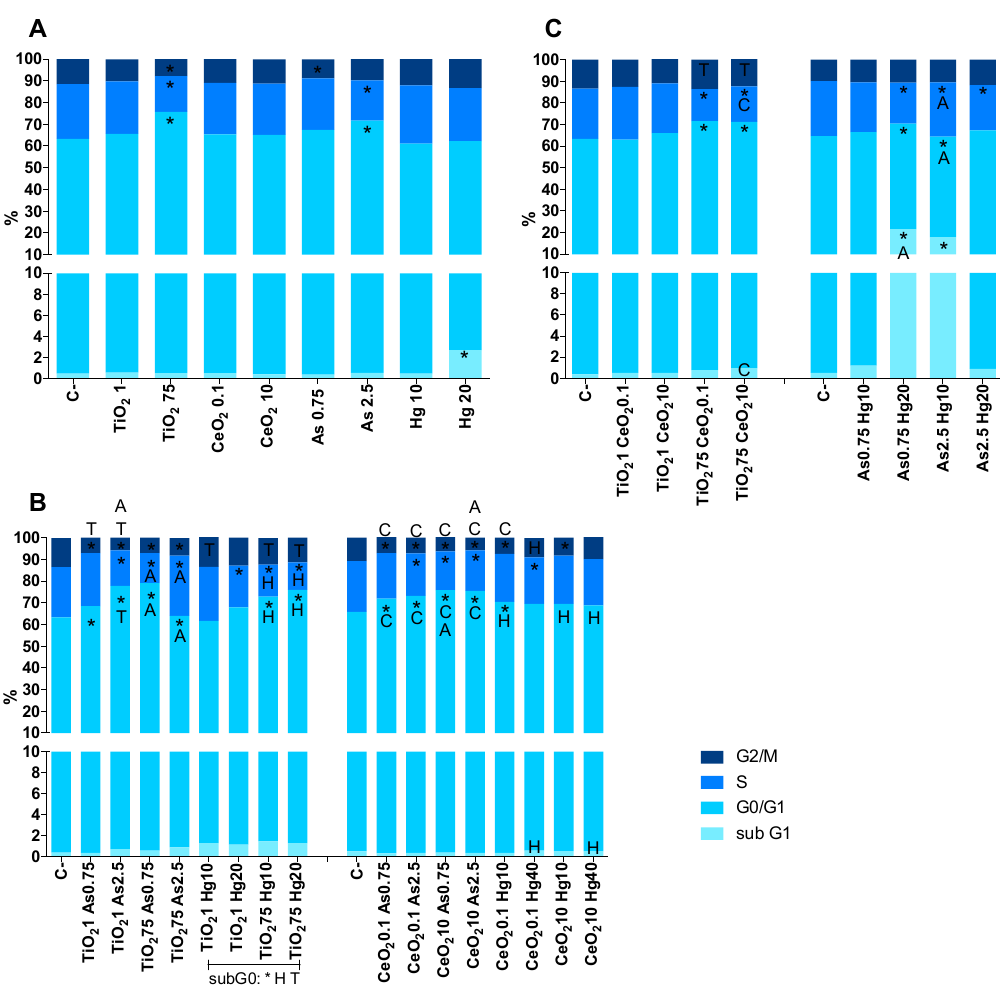
Figure 11. Cell cycle and sub G 1 A549 cell population observed after 24 h exposure to ( A ) single substances; ( B ) binary mixtures of NP-metals; and ( C ) binary mixtures of TiO 2 NP and CeO 2 NP and As-Hg. Values are expressed as mean ± standard deviation (n = 3, each experiment in triplicate). All concentrations expressed in mg/L with the exception of CeO 2 NP which is expressed in μ g/L. Statistical differences (One ‐ way ANOVA; p ≤ 0.05) against *: negative control; T: TiO 2 NP single; C: CeO 2 NP single; A: arsenic single; and H: mercury single exposure.